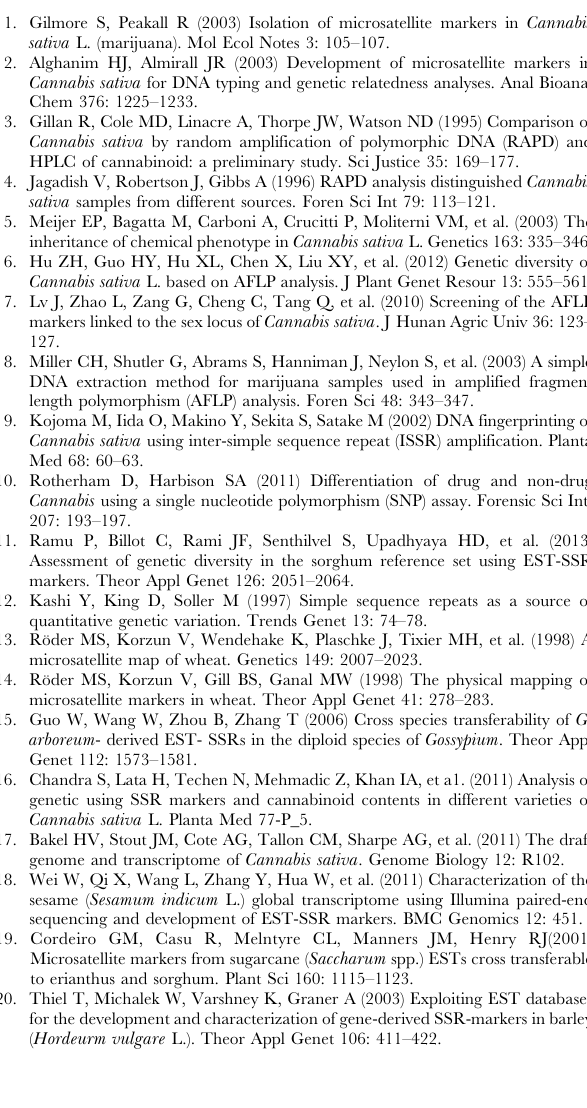
Table S2 One hundred and seventeen EST-SSR markers used for PCR amplification. Table S3 The information of 3443 EST-SSR markers developed.